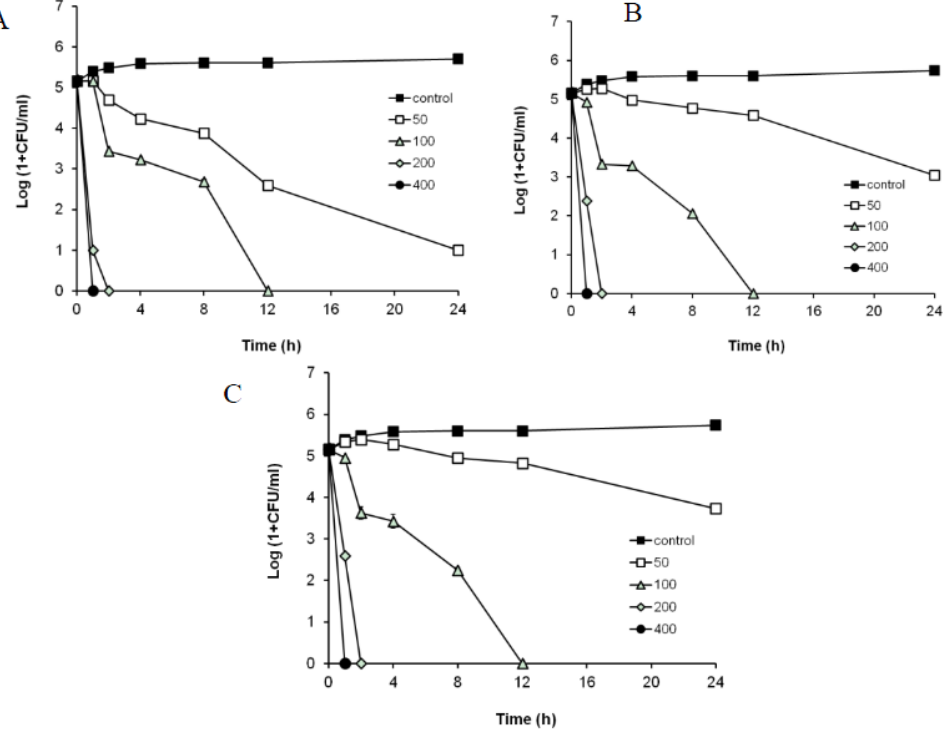
Figure 2. Time-kill curve of R1-barrigenol from P. tobira against P. gingivalis ( A ), P. intermedia ( B ), and F. nucleatum ( C ) growth. R1-barrigenol (50–400 μ g/mL) completely kills all the strains after 12